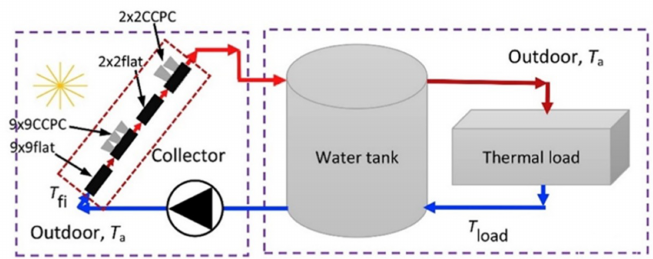
Figure 1. Schematic of the two-stage hybrid roof-top Concentrator photovoltaics/thermal (CPV/T) system